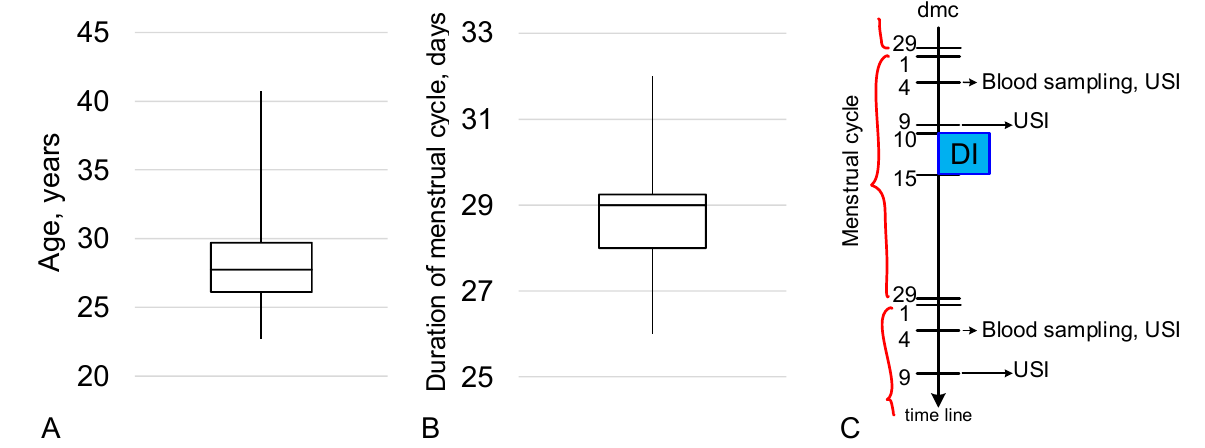
Figure 5. Characteristics of the group of subjects. ( A ) Average age of the subjects. ( B ) Duration of the menstrual cycle. ( C ) Cyclogram of the study of the state of the reproductive system. dmc—day of menstrual cycle, DI—“dry” immersion, USI—ultrasound imaging. The cyclogram is given for the average duration of the menstrual cycle in the group of subjects (29 days) and the start of exposure at 10